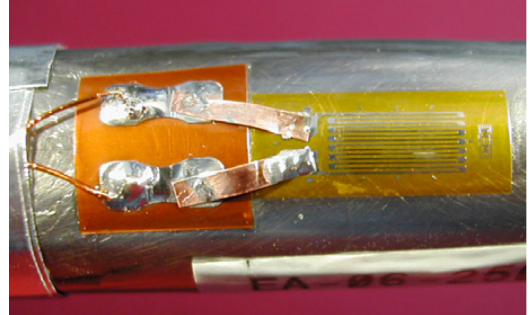
Fig. 4. Copper foil soldered to connection tab and the strain gage’s tab with very thin